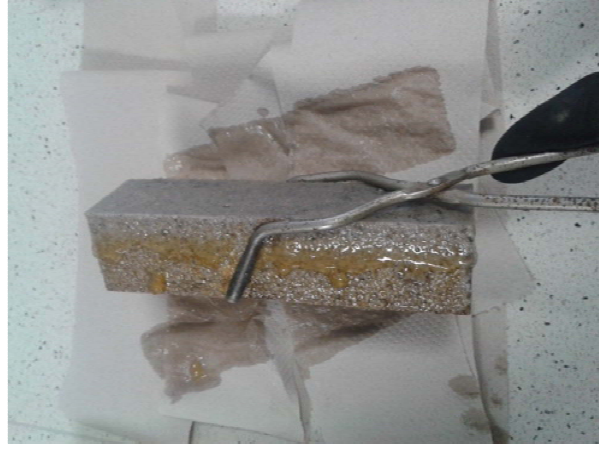
Figure 31. Gel substance on ZIII mortar exposed to 5% hydrochloric acid solution after 365 days.